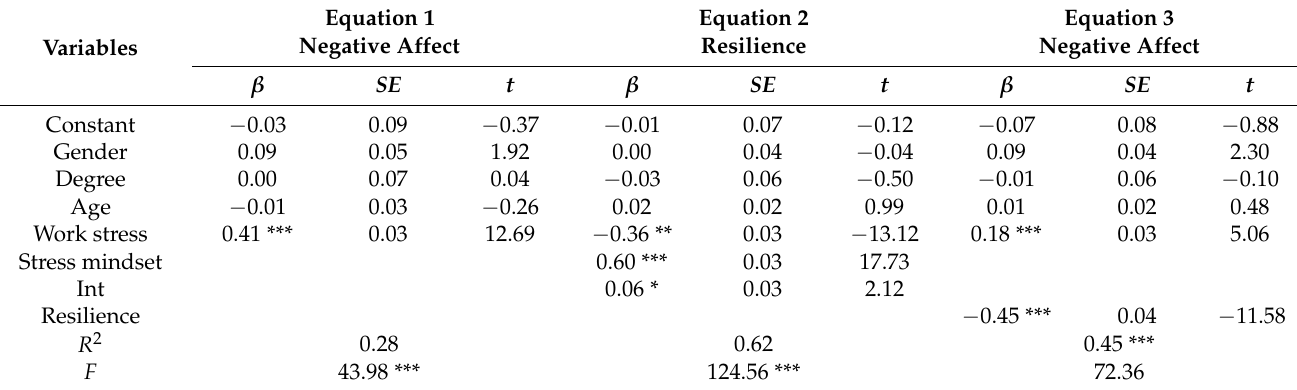
Table 4. Moderated mediating effect of work stress on negative affect ( N =